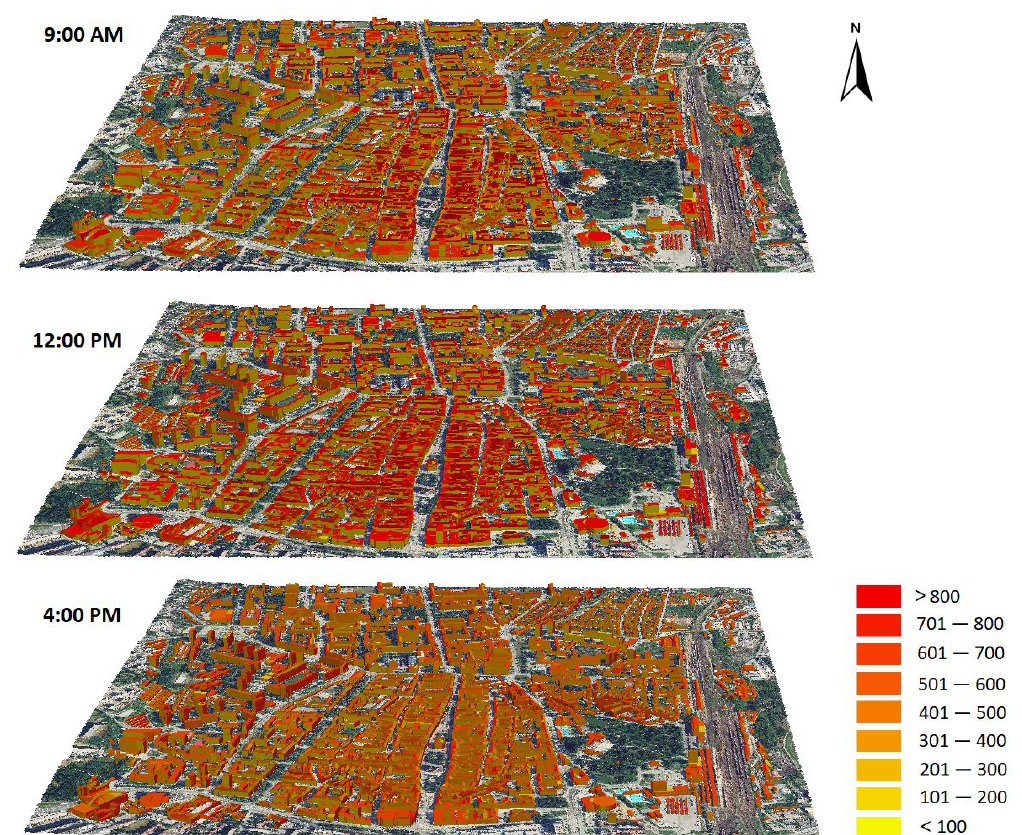
Figure 4. Solar irradiance from the v.sun model in the city center of Košice on 23 June 2021 (W/m 2 ).